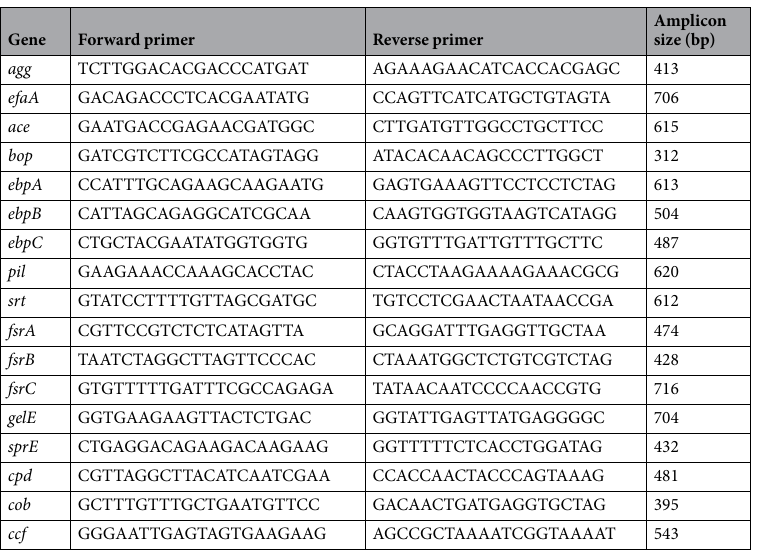
Table 2. Specific primer pairs used in this study.